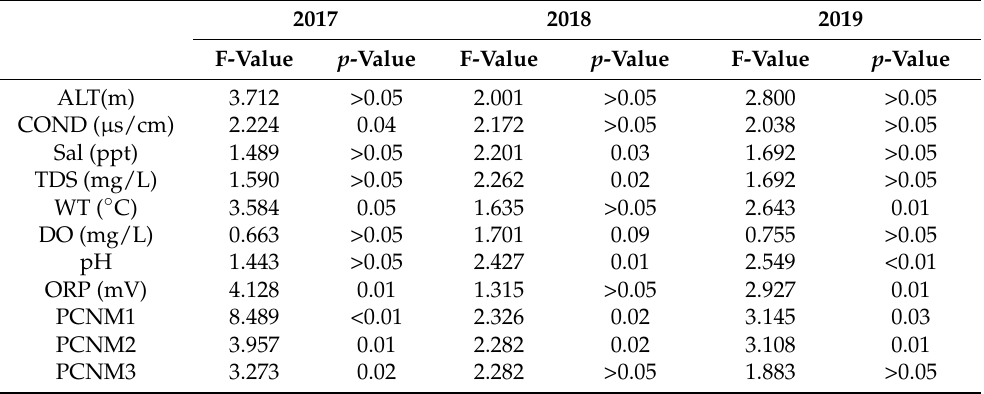
Table 2. Results of the forward selection method in the Redundancy Analysis for three years time periods .